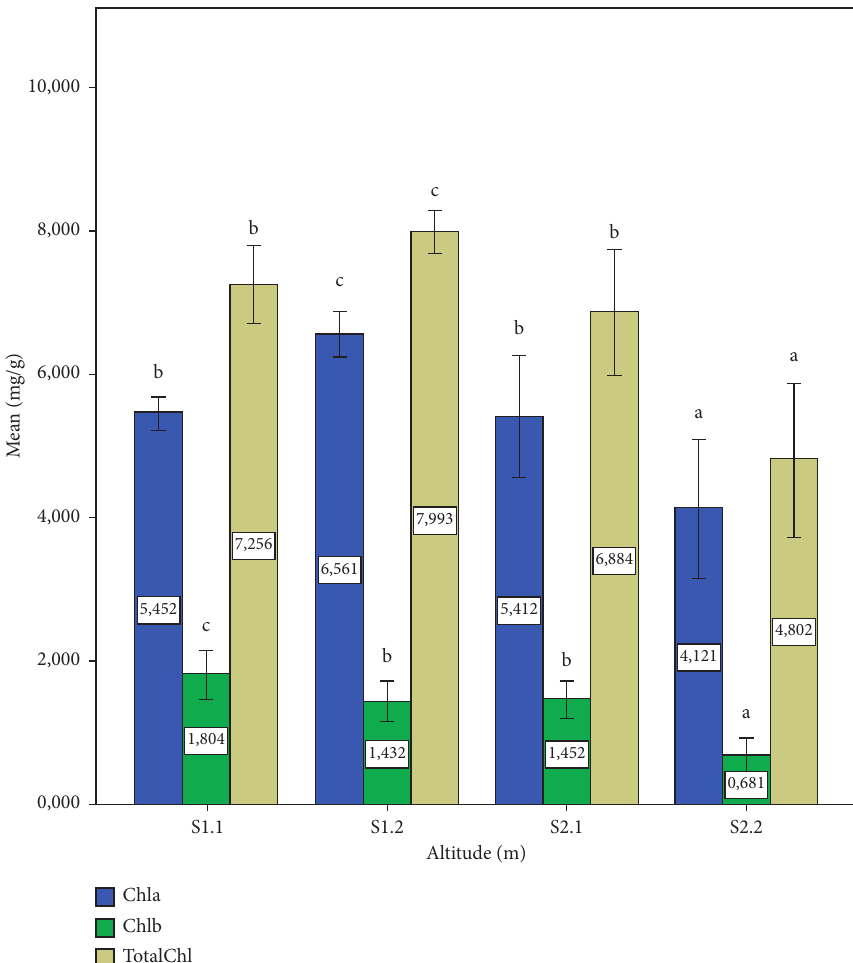
Figure 1: Chlorophyll a, b, and total chlorophyll content the P. lentiscus L. leaves at different altitudes. Data are means of three replicates. Vertical bars represent the standard deviation of the mean. Values not sharing a common letter indicate a significant difference at p ≤ 0 . 05, based on the SNK test. Chl a: Chlorophyll a, Chl b: Chlorophyll b, and Total Chl: total chlorophyll. S: site, S1.1 � 1400m, S1.2 � 1120, S2.1 � 780 m, S2.2 �